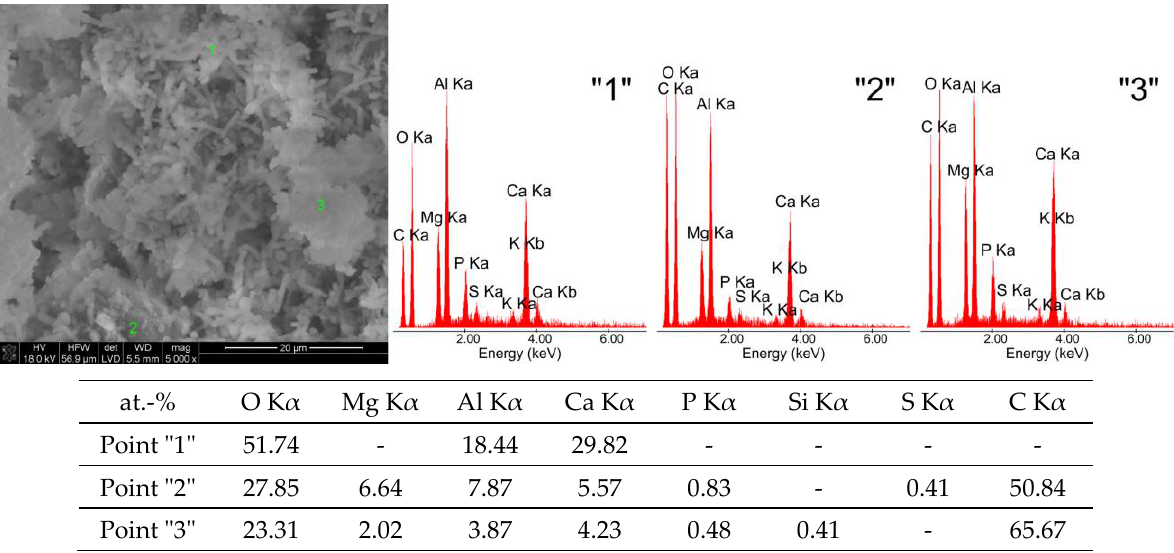
Figure 6. SEM microphotographs of tricalcium aluminate after exposure in chicken manure (P) and EDS quantitative point analyses of areas 1, 2, 3.